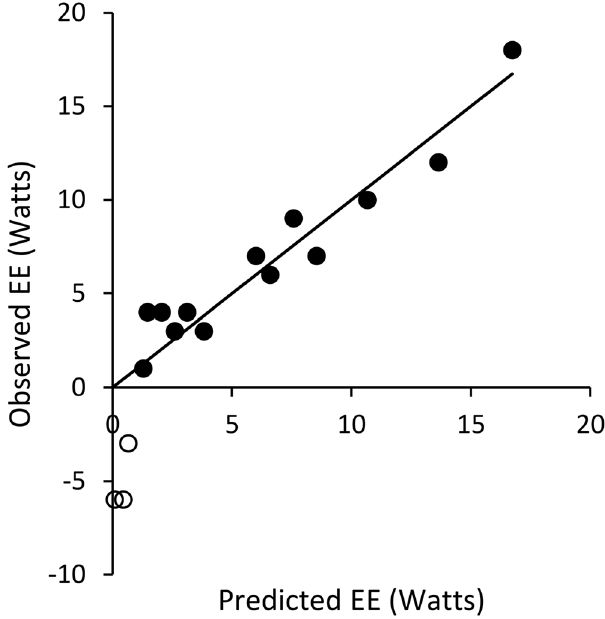
Figure 3. Observed Δ EE plotted against that predicted Δ EE from the least squares regression with V E and HR: Δ EE = 0.44 Δ V E + 0.24 Δ HR; see text. Line indicates y = x. This predictive fit model for data was calculated using the hypoxia-speed conditions with only positive Δ EE values (filled circles), but excluding the hypoxia- speed conditions with negative Δ EE values (open circles).